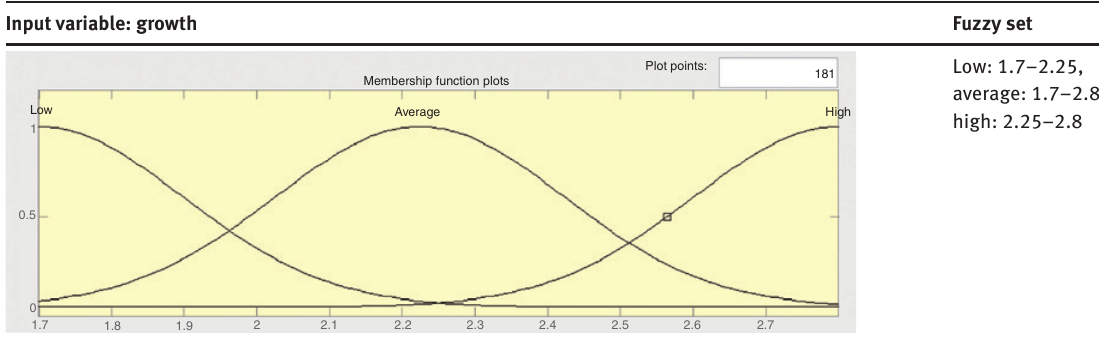
Table 1: Fuzzification of the Input